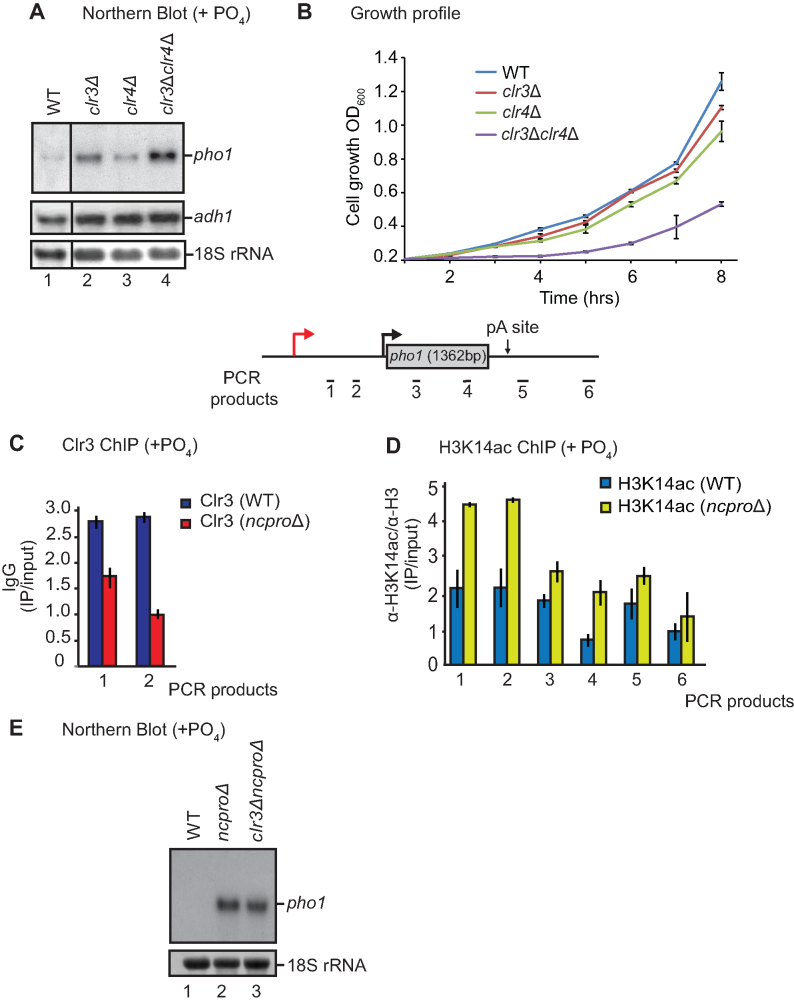
Cumulative effect of Clr3 and Clr4 on heterochromatin establishment. (A) Northern blot analysis of RNA isolated from the indicated strains grown in YES. adh1 and 18S ribosomal RNA serve as loading controls. Probes used are as in Figure 1A. (B) Growth profile of indicated strains grown in YES media over a period of eight hours. Error bars represent SD of the mean of three independent determinations. Schematic of the pho1 gene is shown with qPCR products indicated by black bars. (C) Clr3 and (D) H3K14ac ChIP-qPCR was performed in wild-type (WT) cells and a strain lacking the prt promoter (ncproΔ). (E) Northern blot analysis of pho1 from RNA isolated from the indicated strains. 18S ribosomal RNA represents a loading control. Probe used is the same as in Supplementary Figure S1A.